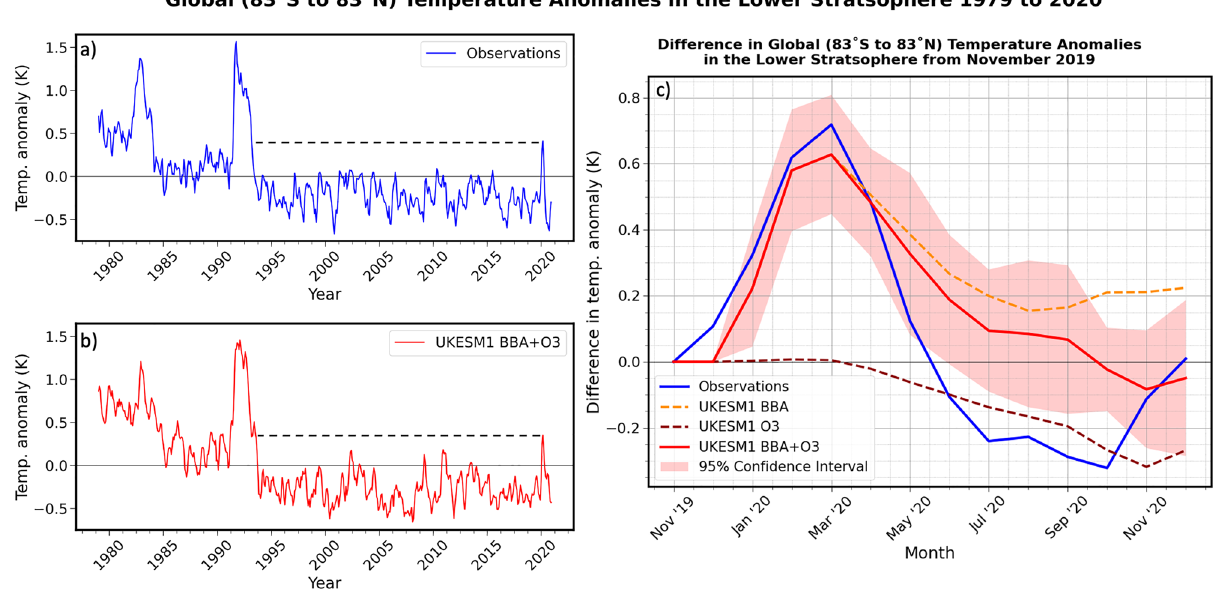
Figure 6. Monthly-mean lower stratospheric temperature (LST) anomalies provided by RSS data ( a ), and the mean of the 10-member ensemble of UKESM1 BBA + O3 simulations ( b ). Temperature anomalies are calculated relative to a 1979–2019 reference period, and averaged over latitudes 83˚S to 83˚N. The difference in the LST anomalies relative to November 2019 are shown in ( c ). The BBA, O3 and BBA + O3 temperature anomalies shown in ( c ) are the differences from the control simulation. In addition, the 95% confidence intervals for the BBA + O3 experiment for each month of 2020, assuming a Student’s t-distribution, are shown in